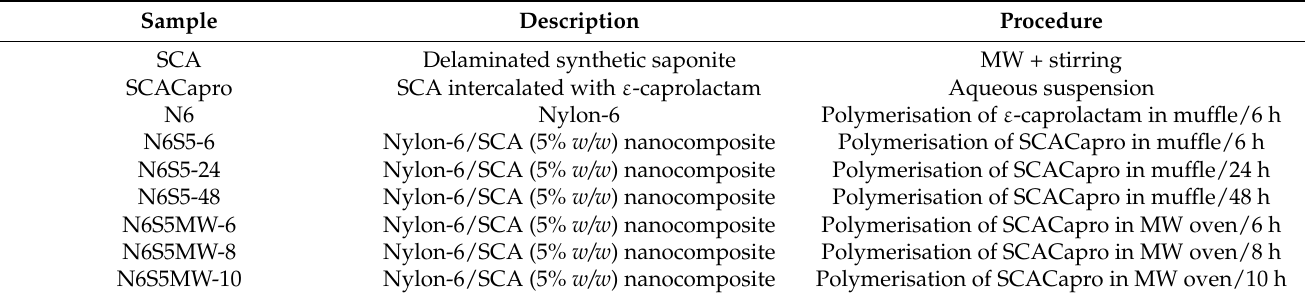
Table 1. Preparation procedure and naming of the samples